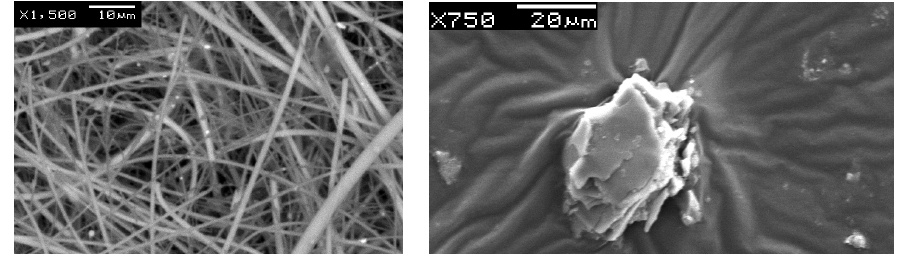
Fig. 10. SEM images of aerosol particles obtained from ground-based and airborne measurements. Left: image of a filter used in the sequential sampler on 17 April 2010 (1500-fold magnification). Bright points on the filter were found mostly to be ash particles. Right: image of an agglomerate ash particle collected at the altitude of 2.2kma.s.l. (750-fold magnification).